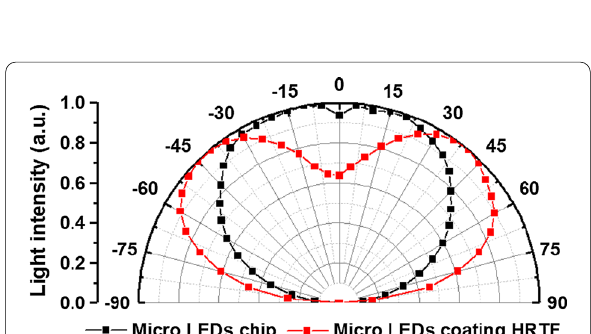
Fig. 13 Light distribution curves of bare and HRTF‑coated micro‑LEDs